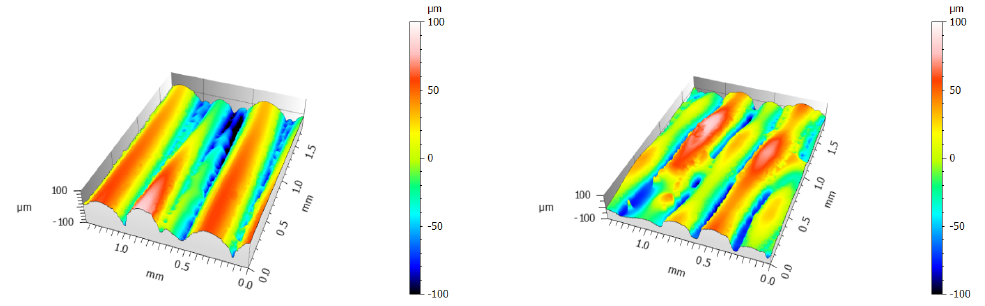
Figure 20. Roughness scans of the horizontal, downward 90° overhang. Prusa ( left ) and Rot- Bot ( right ).